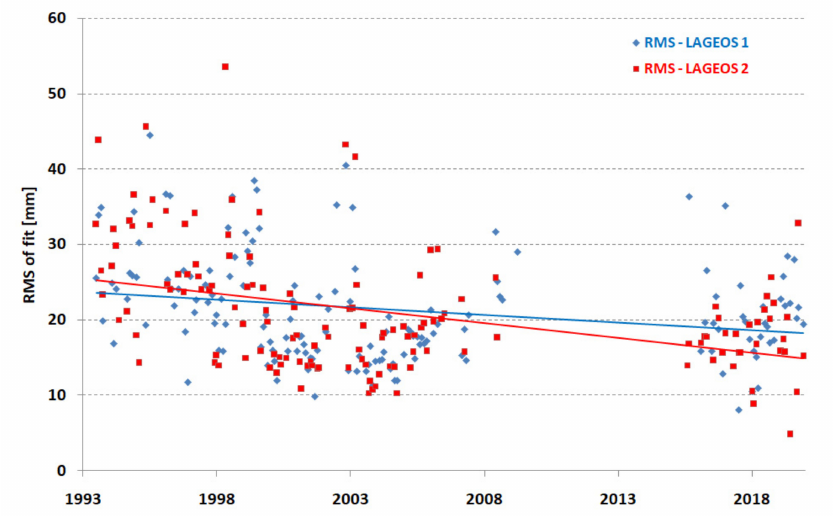
Figure 5. Borowiec SLR station—RMS of the fit of satellites LAGEOS-1 and LAGEOS-2 (monthly